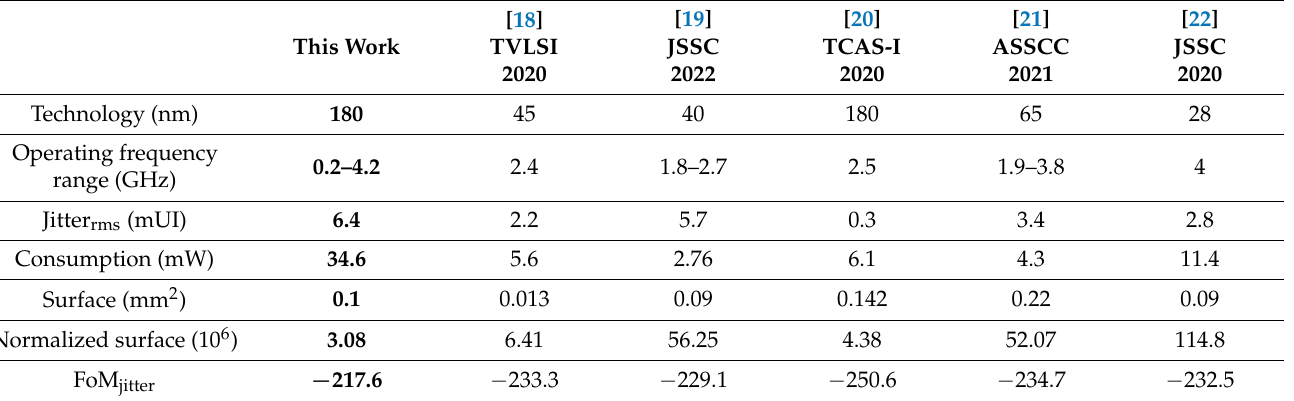
Table 2. Performance comparison to other state-of-the-art